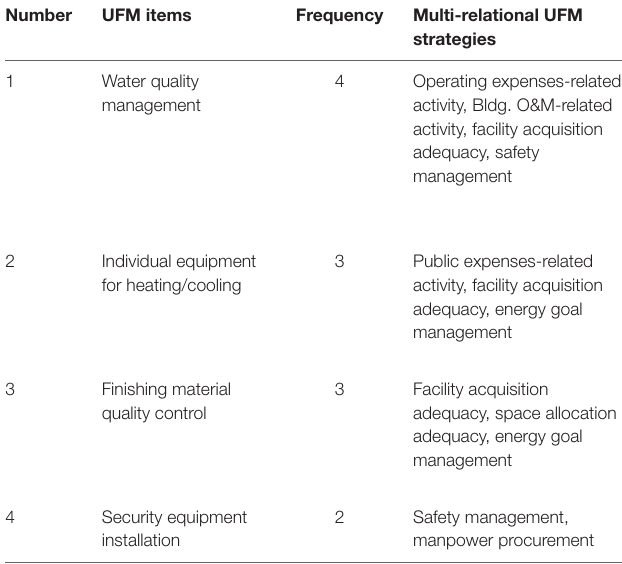
TABLE 5 | UFM items commonly affecting UFM strategies.